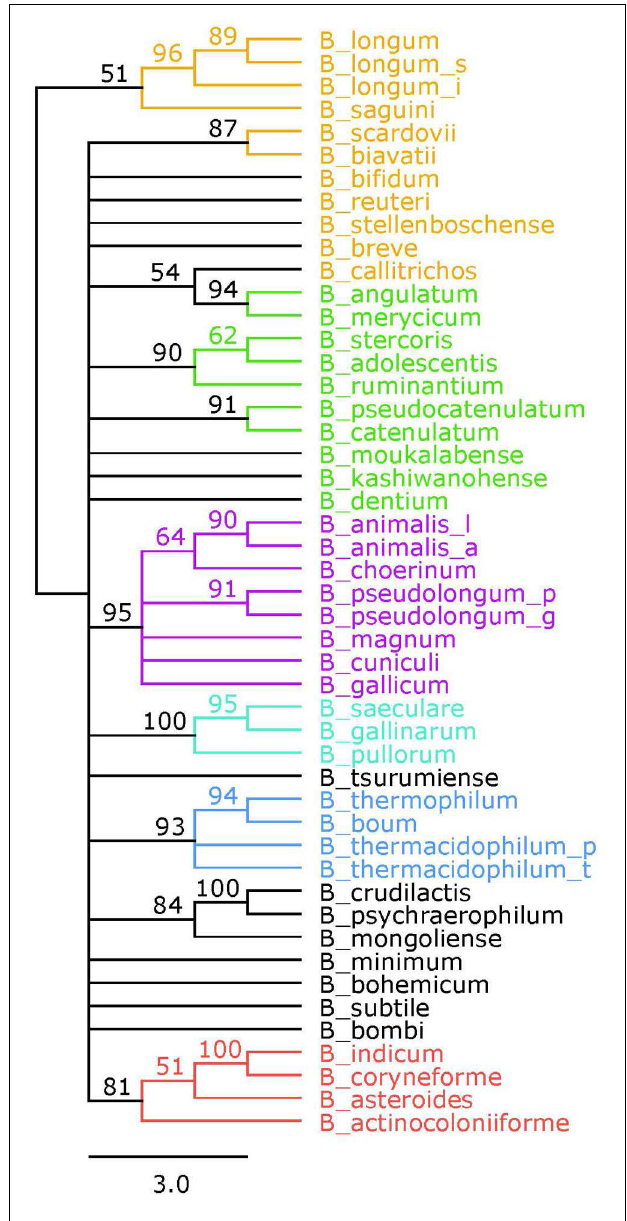
FIGURE 3 | 16S rRNA phylogenetic tree. Consensus tree based on alignment of the 16S rRNA sequences. Trees were made using RaxML. Bootstrap values are found on each node. Phylogenetic groups are colored as follows: B. longum is orange, B. adolescentis is green, B. psdeudolongum is purple, B. pollorum is blue-green, B. boum is blue, and B. asteroides is red. Species names follow the naming convention from Table 1